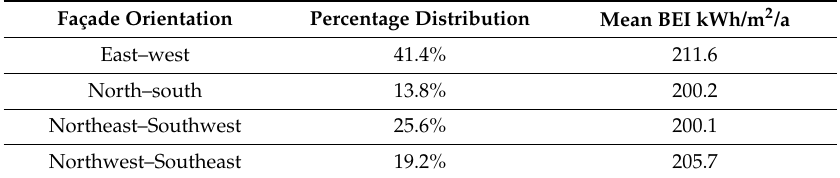
Table 4. Prevalent orientations of front façade facing the road and mean building energy index